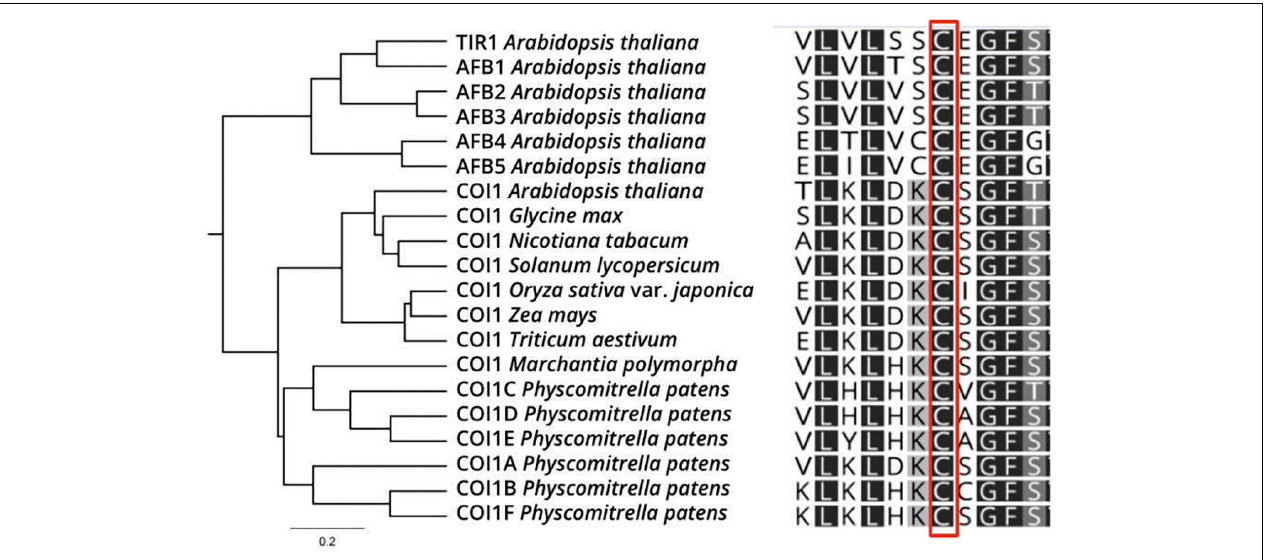
FIGURE 4 | COI1 as a putative S-nitrosation target. COI1 orthologs of select plant species are aligned, showing the conservation in Cys148. Color code: dark gray: 100% similarity; medium gray: 80–100% similarity; light gray: 60–80% similarity; white: less than 60% similar. TABLE 1 | Computational prediction of S-nitrosation sites from AtCOI1 protein using GPS-SNO 1.0, iSNO-PseAAC, iSNO-AAPair, DeepNitro, and pCysMod software. Protein Predicted SNO site position Software Sequence